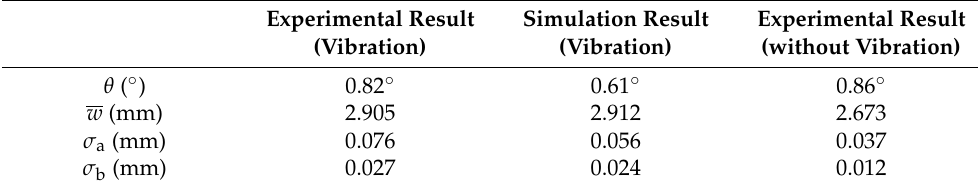
Table 3. Evaluation of the machined channel